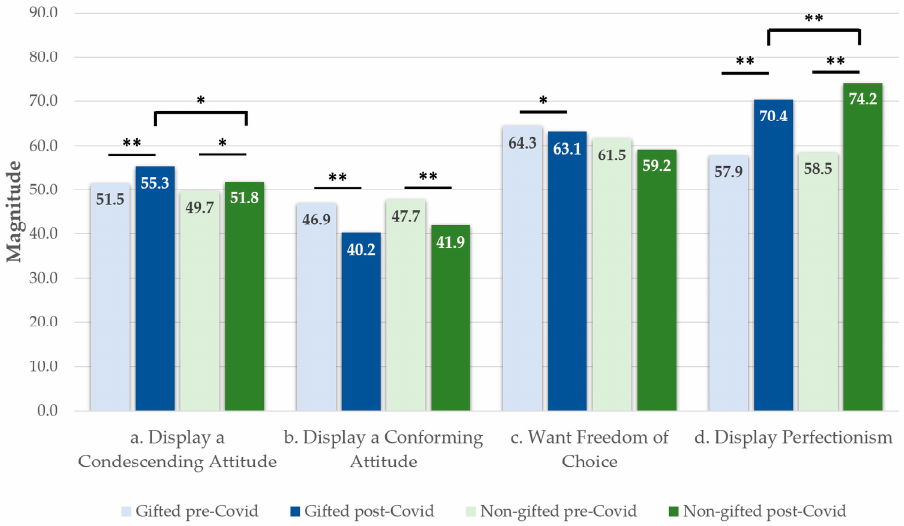
Figure 3. Pre- and post-COVID-19 attitudes in gifted and non-gifted children. (Student’s t -test, * p < 0.05, ** p < 0.01). The four metrics are represented in the figure. Bars represent values within each study group.